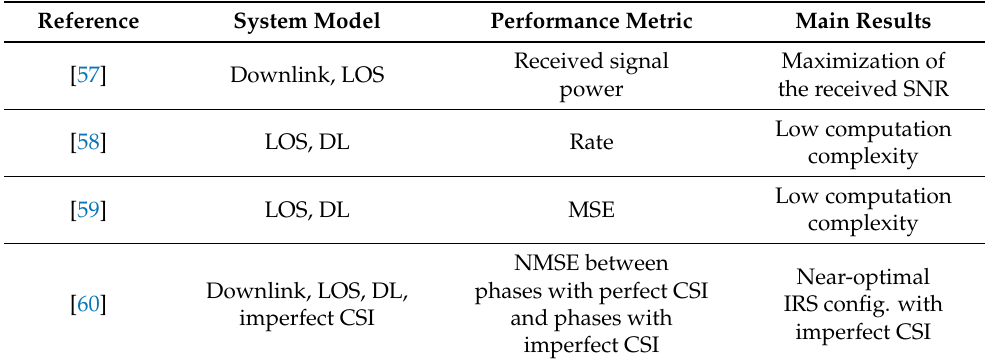
Table 3. Single-user MISO/SIMO